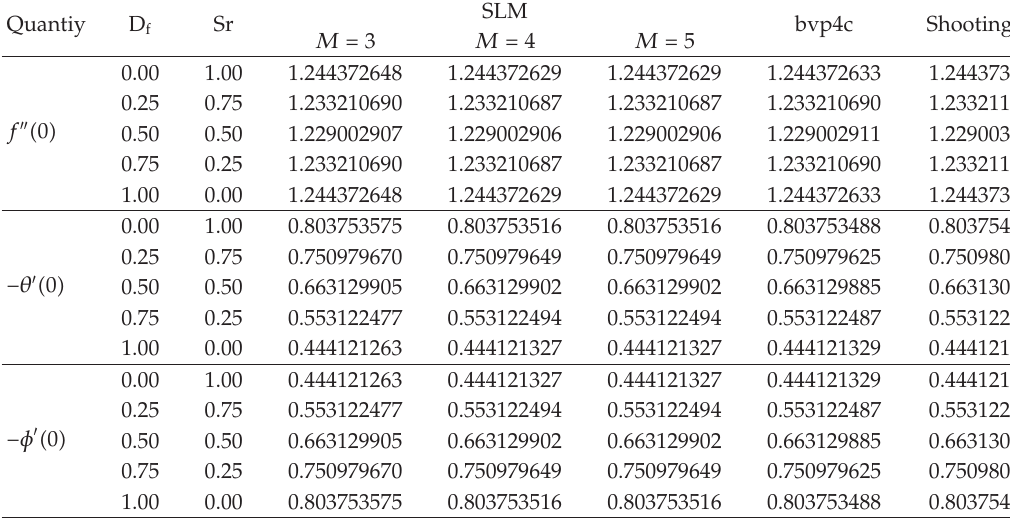
Table 2: Comparison of f (cid:5)(cid:5) (cid:3) 0 (cid:4) , − θ (cid:5) (cid:3) 0 (cid:4) , and − φ (cid:5) (cid:3) 0 (cid:4) obtained by SLM with bvp4c and shooting methods for di ff erent values of D f and Sr with λ (cid:10) Pr (cid:10) Sc (cid:10)